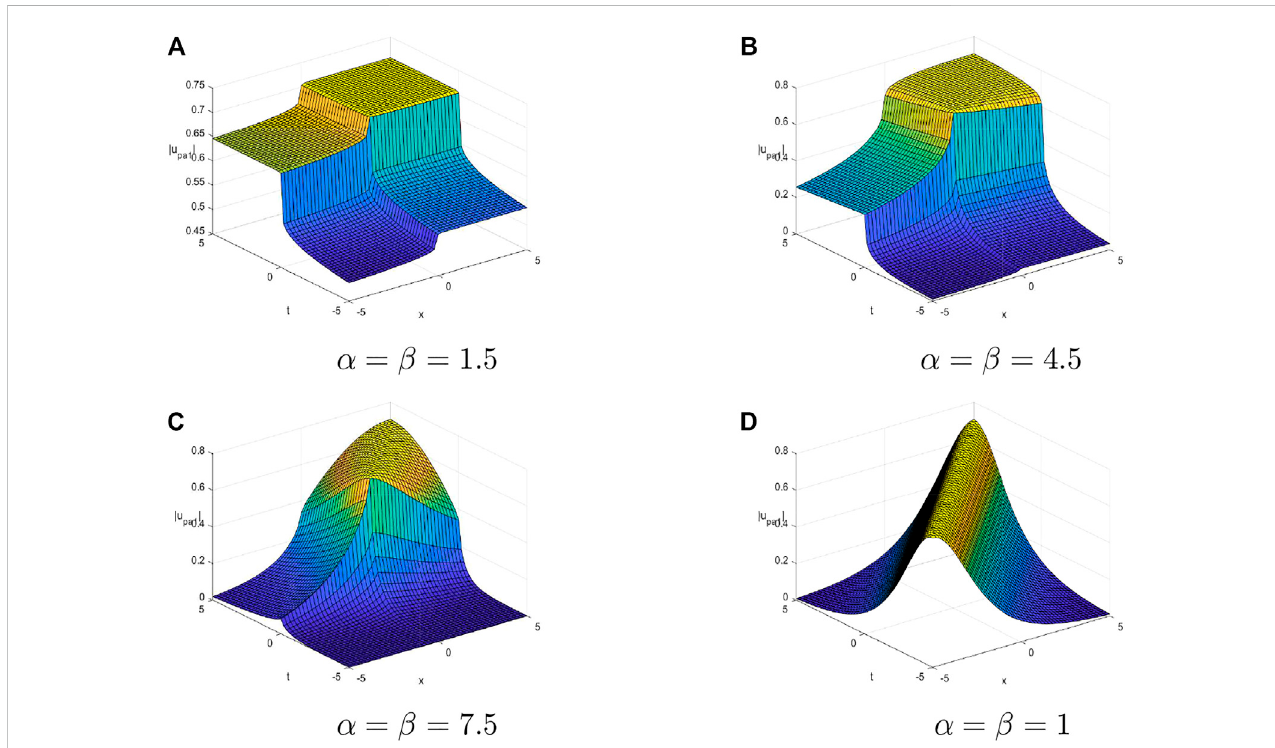
FIGURE 3 3Dplotsofbrightsolitonsolutionsfortheparaboliclawnon-linearitywiththefourdifferentfractionalvaluesbyconsideringthevalues A 1 =1, B = − 1, v =1, κ = − 1, ω = 3, and δ = 1. (A) α = β = 1.5. (B) α = β = 4.5. (C) α = β = 7.5. (D) α = β =